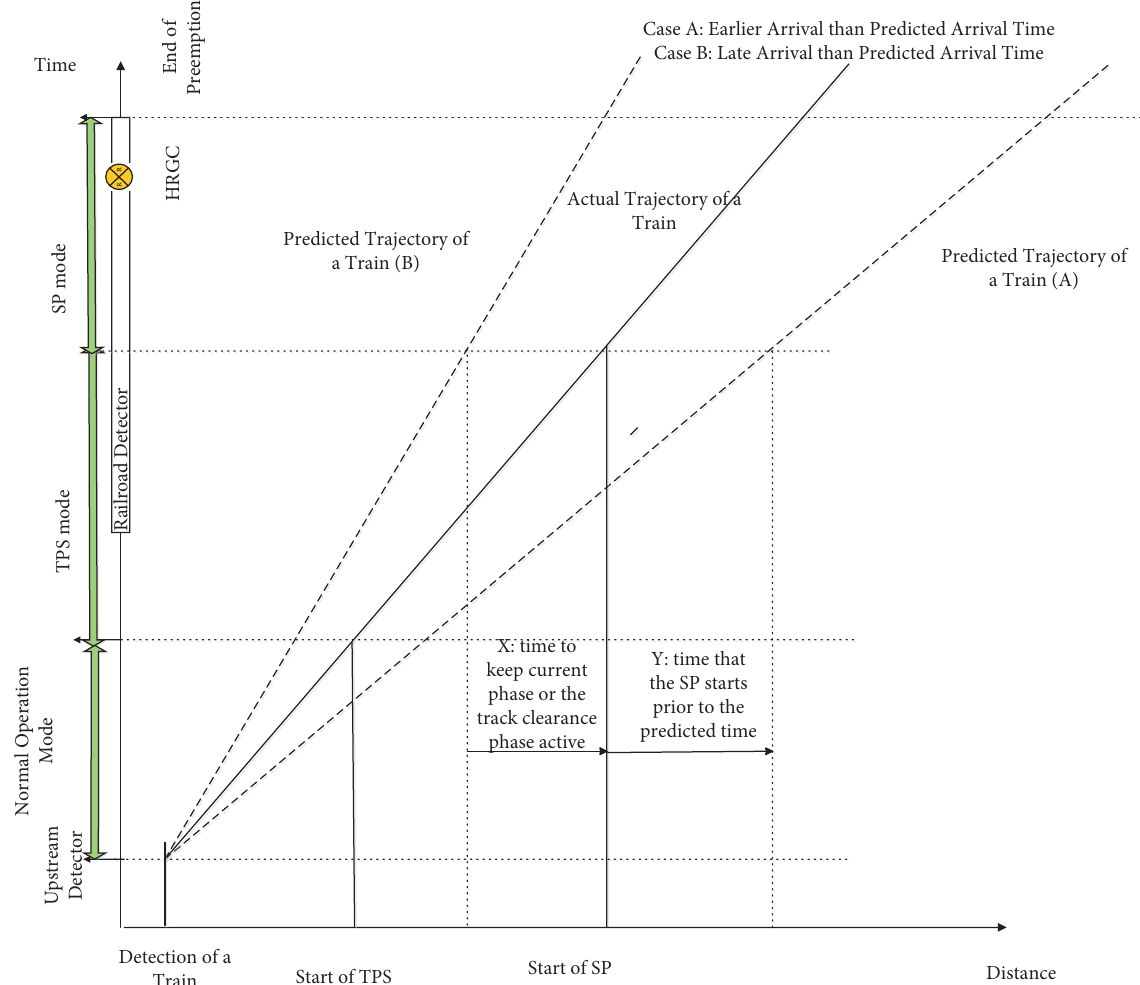
Figure 7: Train prediction errors and the resultant responses in the TPS_DT